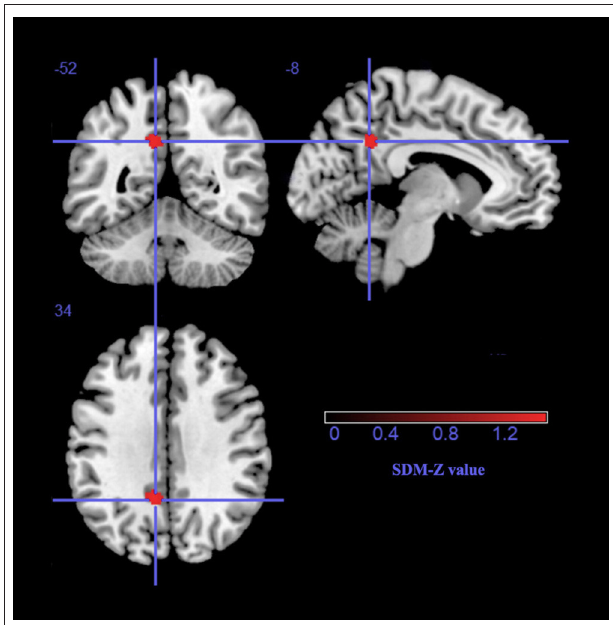
FIGURE 1 | The gray matter volume reduction in the left precuneus extending to the left posterior cingulate gyrus, BA 23. SDM, Seed-based d